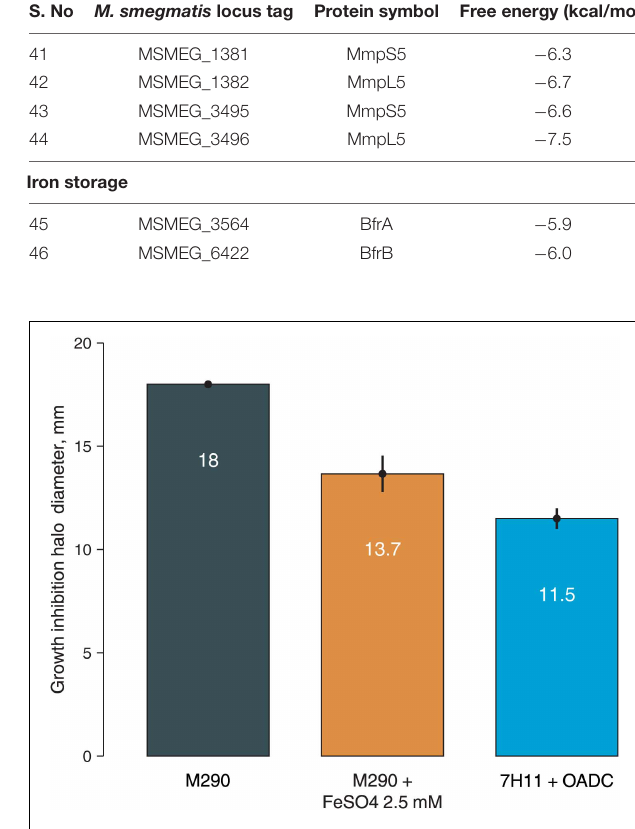
FIGURE 3 | Growth inhibition halos, produced by 3a (300 nmol/disk) on M. smegmatis mc2 155 on different media: soyabean digest agar (M290), soyabean digest agar + 2.5 mM FeSO 4 , and 7H11 + OADC. Columns represent the average growth inhibition halo diameters, while the error bars represent the standard deviation, calculated from three